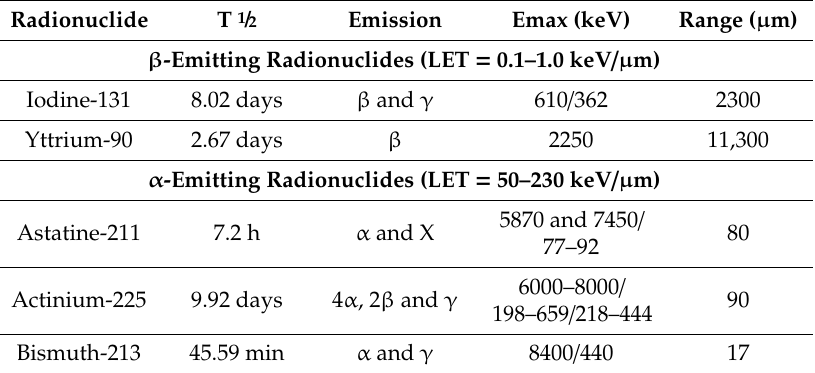
Table 3. Radionuclides used in active clinical trials for